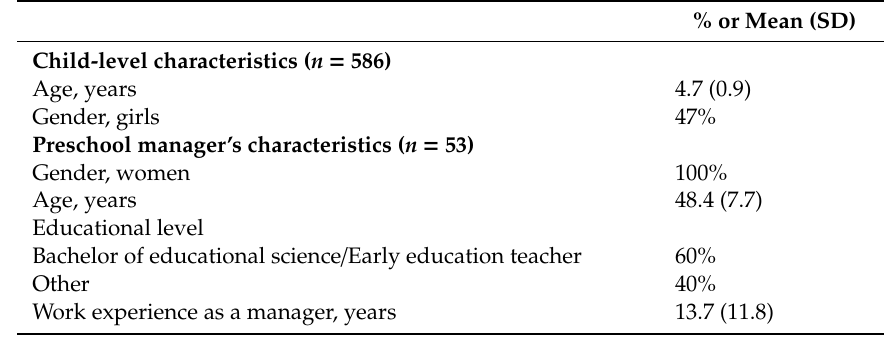
Table 3. Characteristics of the children and of the preschool managers.